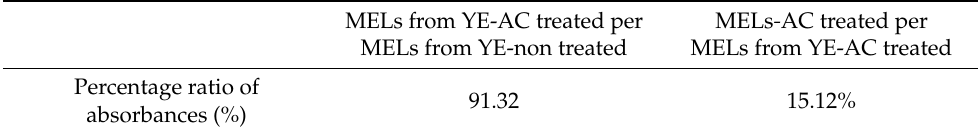
Table 5. Absorbance reduction due to AC treatment of YE or AC of the crude. MELs from YE-AC treated per MELs - AC treated per MELs from YE-non treated MELs from YE-AC